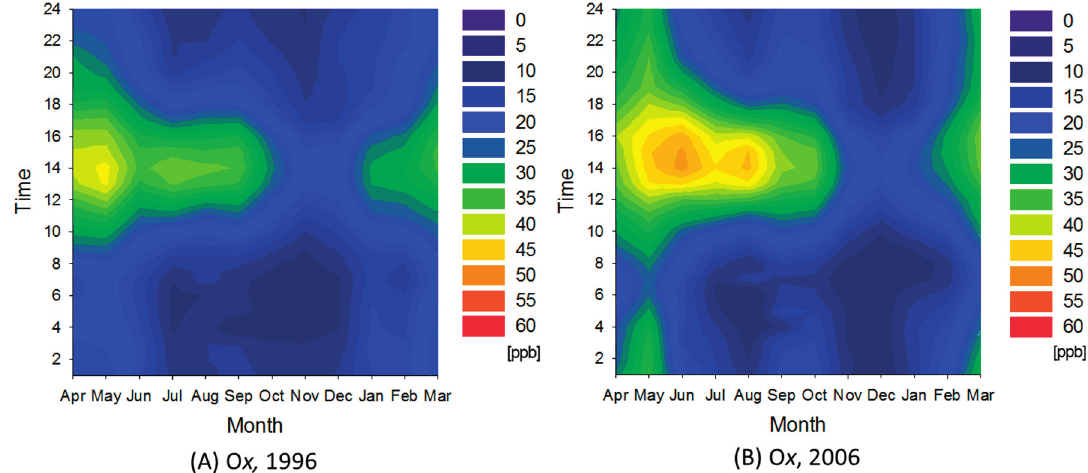
Figure 11. Contour maps for O x in cluster 7 during 1996 and